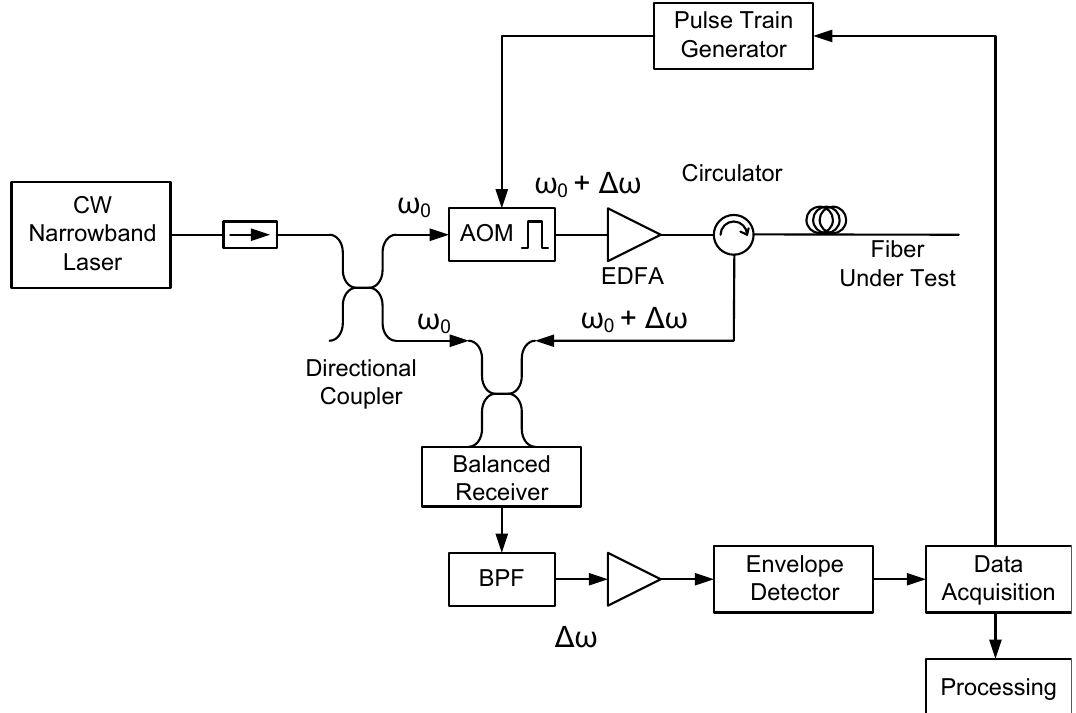
Figure 2. Block diagram of the DAS system used in the present